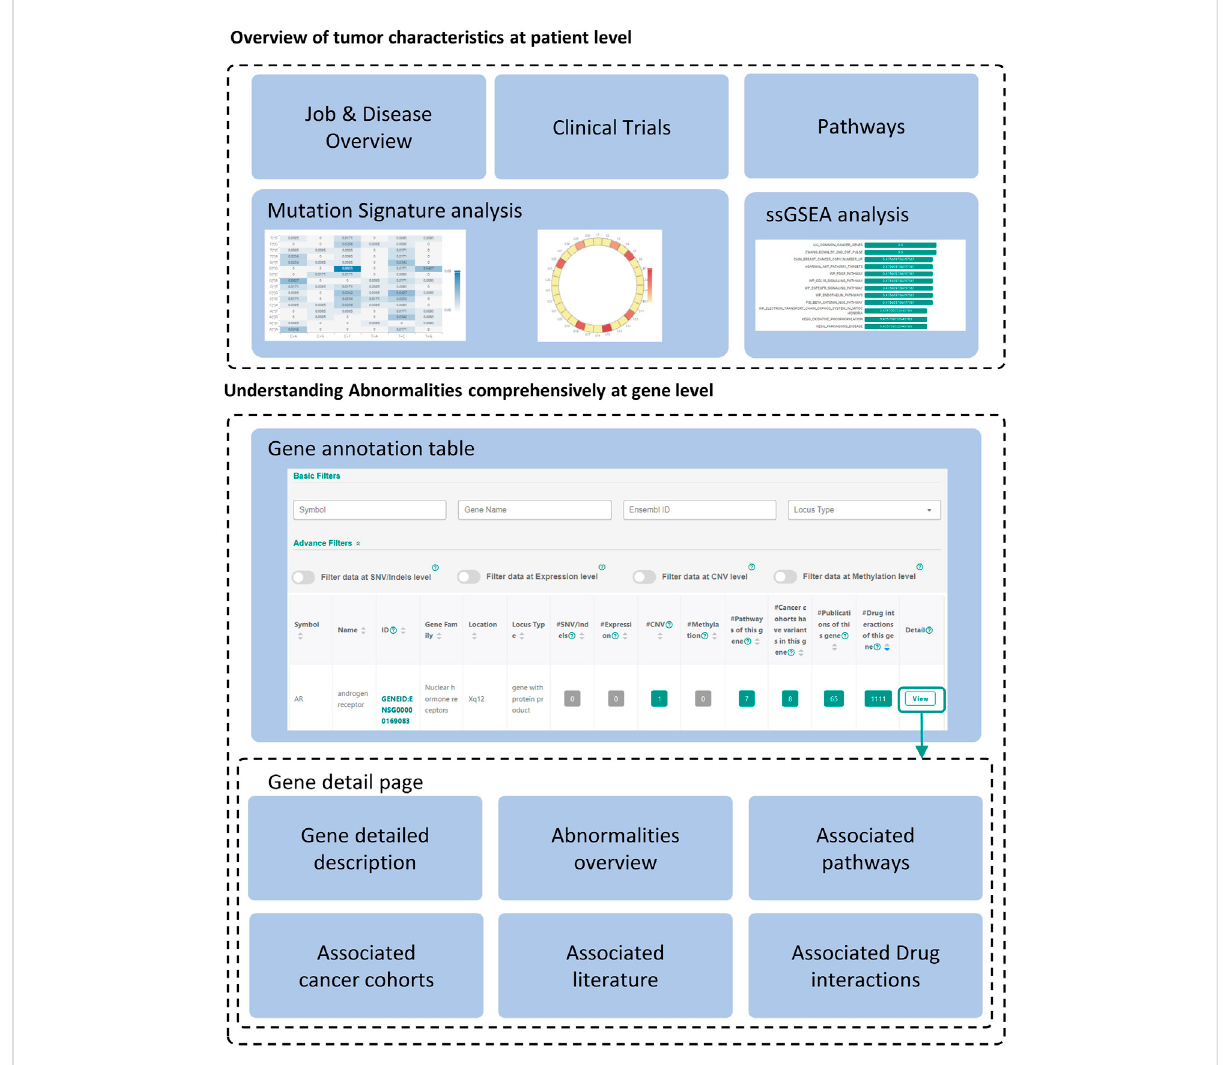
FIGURE 3 Overviewoftheannotationresults.TheannotationresultsofCCASconsistsofpatientlevelannotationandgenelevelannotation.Genedetailed pages can be viewed by clicking “ View ” button at the end of each record in the gene annotation